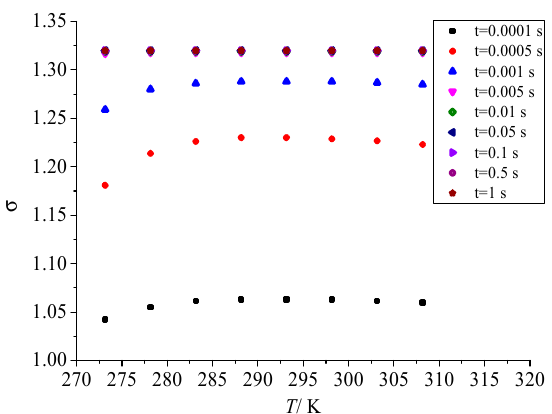
Figure 13. Effect of temperature on the total number of dimensionless particles.